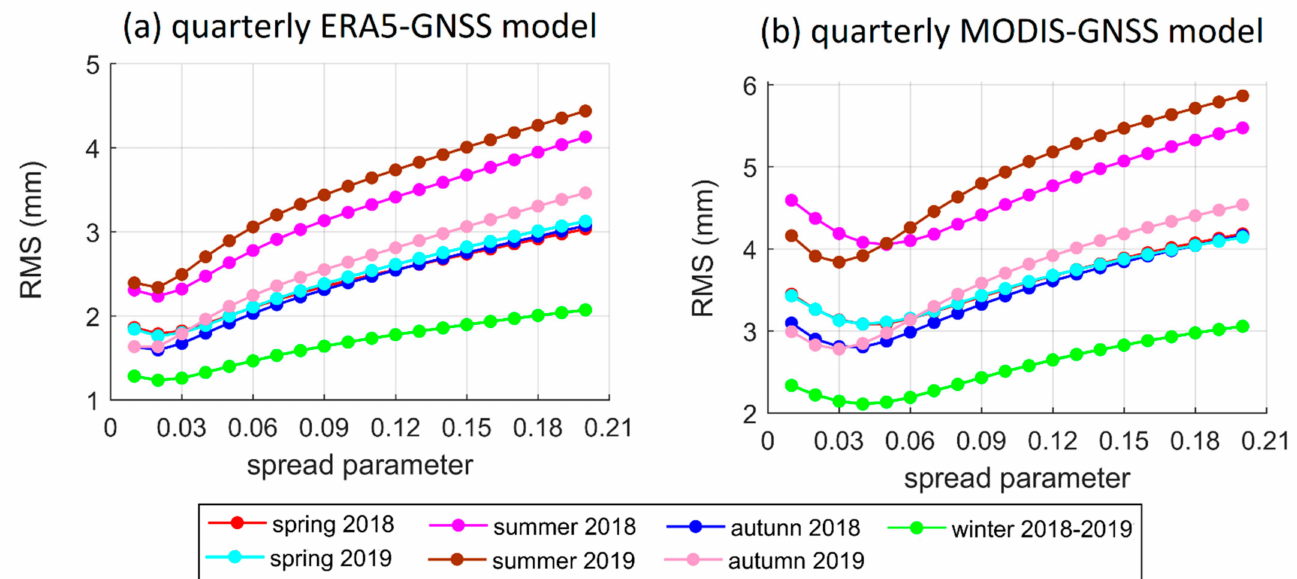
Figure A1. Annual model performance against spread parameter values.